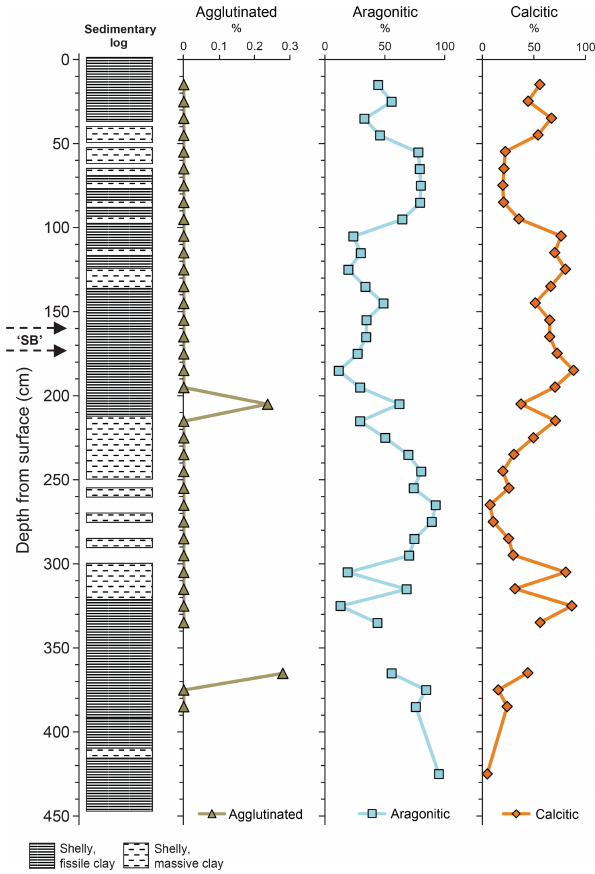
Figure 4. Distribution of foraminifera (agglutinated, aragonitic, calcitic). Adapted from Hart et al. (2016a) with permission.